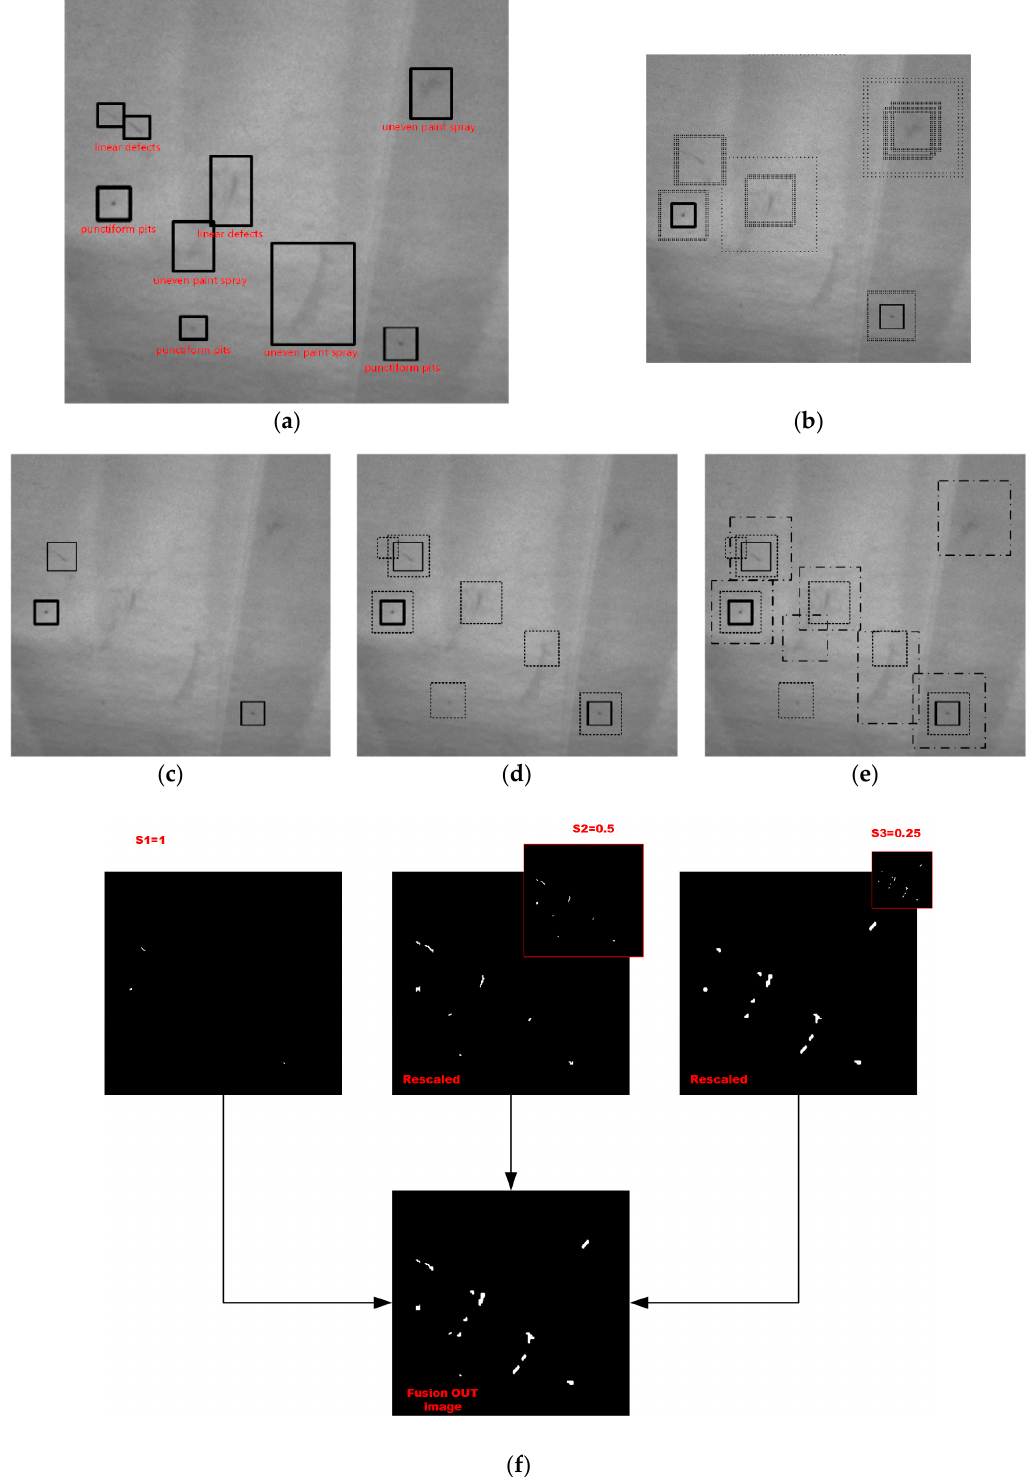
Figure 10. Illustration of three level scales detection process ( a ) ground truth of surface defects ( b ) detection result of enhancement background subtraction of three-level detection method proposed by Jaime Molina [2] ( c ) our first scale level detection represented by a small solid-line box, ( d ) our second scale level detection represented by a broken-line box ( e ) our third scale level detection by a large dotted-line box ( f ) our final fusion candidate defect image.